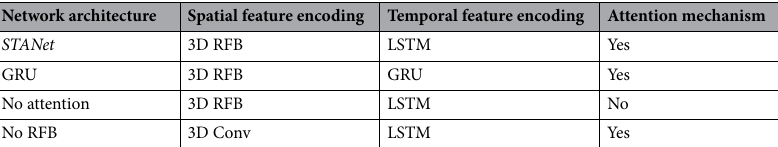
Table 2. The proposed STANet and three cases of ablation experiments for comparative analysis on spatiotemporal representation learning according to feature encoding